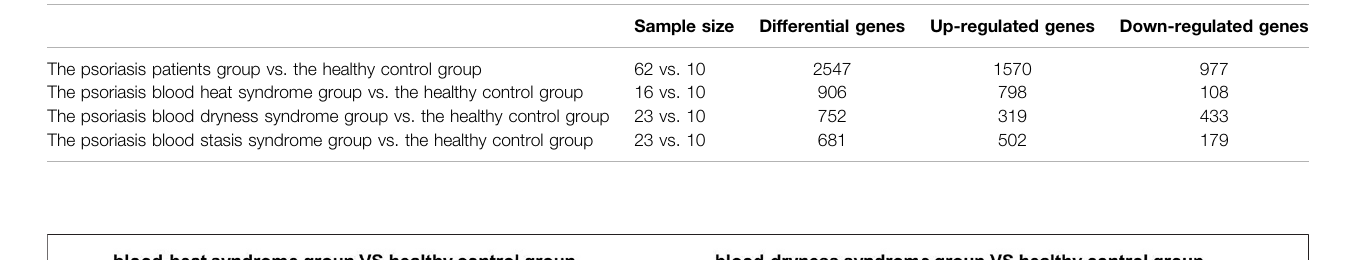
Sample size Differential genes Up-regulated genes Down-regulated genes